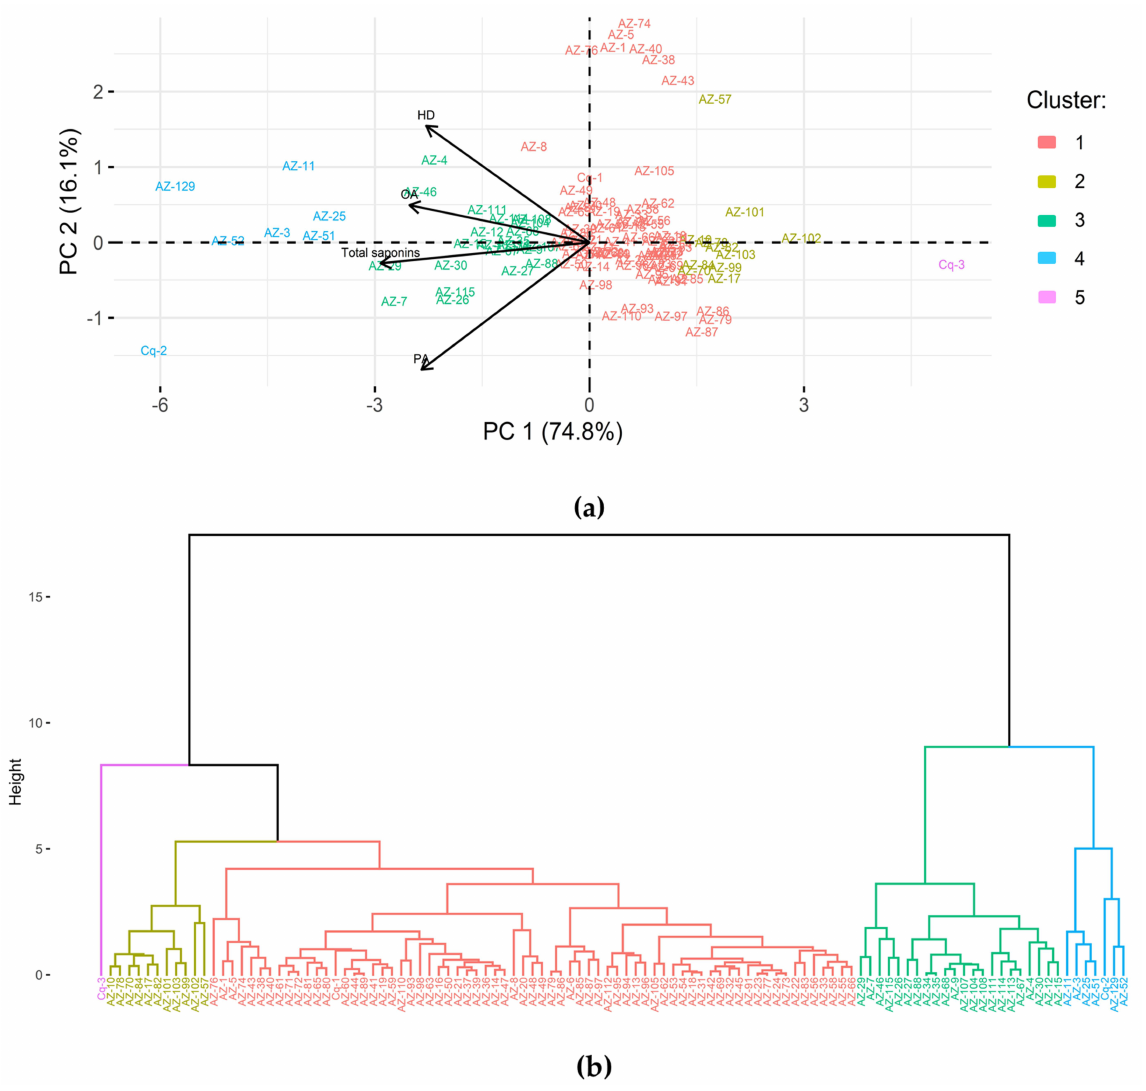
Figure 5. Principal component analysis ( a ) and hierarchical cluster ( b ) of triterpenoid saponins of C. quinoa . Bi-plot showing that two main components PC1 and PC2 explained 90.9% of the total variation in saponin content. Arrows represent each variable and the length of arrows approximates the variance of the variables, whereas the angle between arrows indicates their correlation. The scores of each quinoa genotype are outlined as points. The distance between each point explains how similar the observations are to each other. The cluster colors correspond to the cluster numbers in the legend of a panel ( a